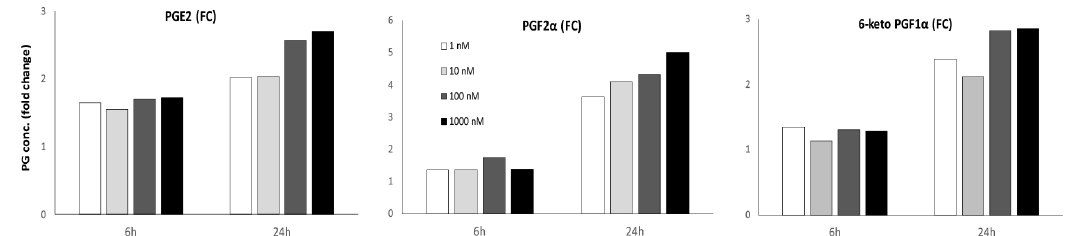
Figure 8. Effect of bradykinin on prostaglandin synthesis by equine trophectoderm cells. Cells were incubated in the presence of bradykinin (1, 10, 100 and 1000 ng/mL) for 6 and 24 h or with serum free medium for 6 h (negative control). The concentrations of PGE2, PGF2 α and 6-keto PGF1 α (pg/mL) were measured in the culture media, and are depicted as the fold change for a given treatment versus the negative control. The analysis was performed on three independent experiments, with three replicates per condition. Bradykinin stimulation resulted in increased production of all prostaglandins. After 24 h, there was evidence of a bradykinin dose dependent increase for PGE2 secretion ( p < 0.0005) and a tendency for a dose dependent increase in PGF2 α secretion ( p = 0.055), but not in 6-keto PGF1 α